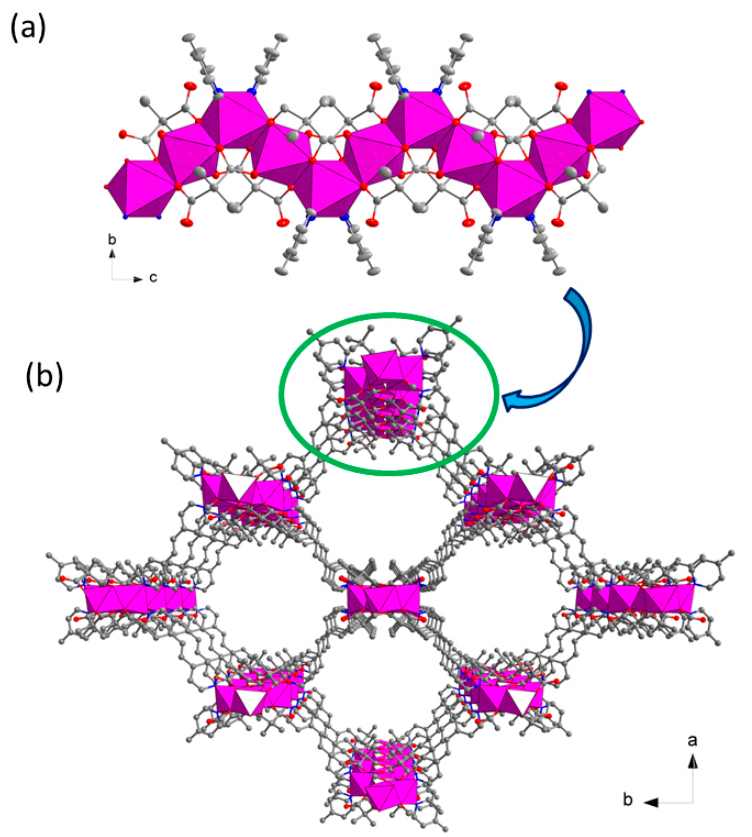
Figure 5. ( a ) View of the 1D edged-shared zigzag Co − Me 2 mal chain along the crystallographic c axis; ( b ) view of the 3D porous structure of compound 2 . The H atoms have been omitted for